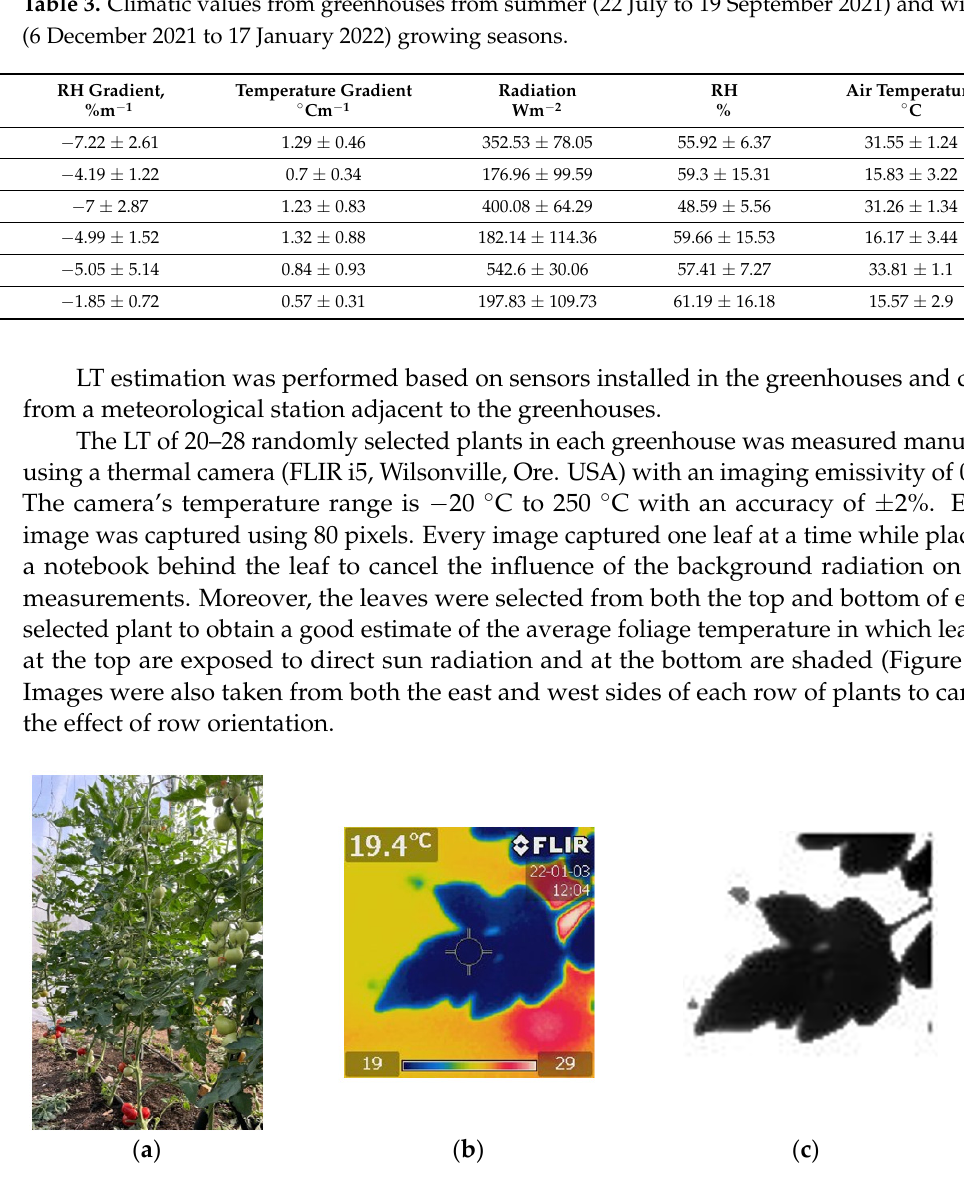
Table 3. Climatic values from greenhouses from summer (22 July to 19 September 2021) and winter (6 December 2021 to 17 January 2022) growing seasons.